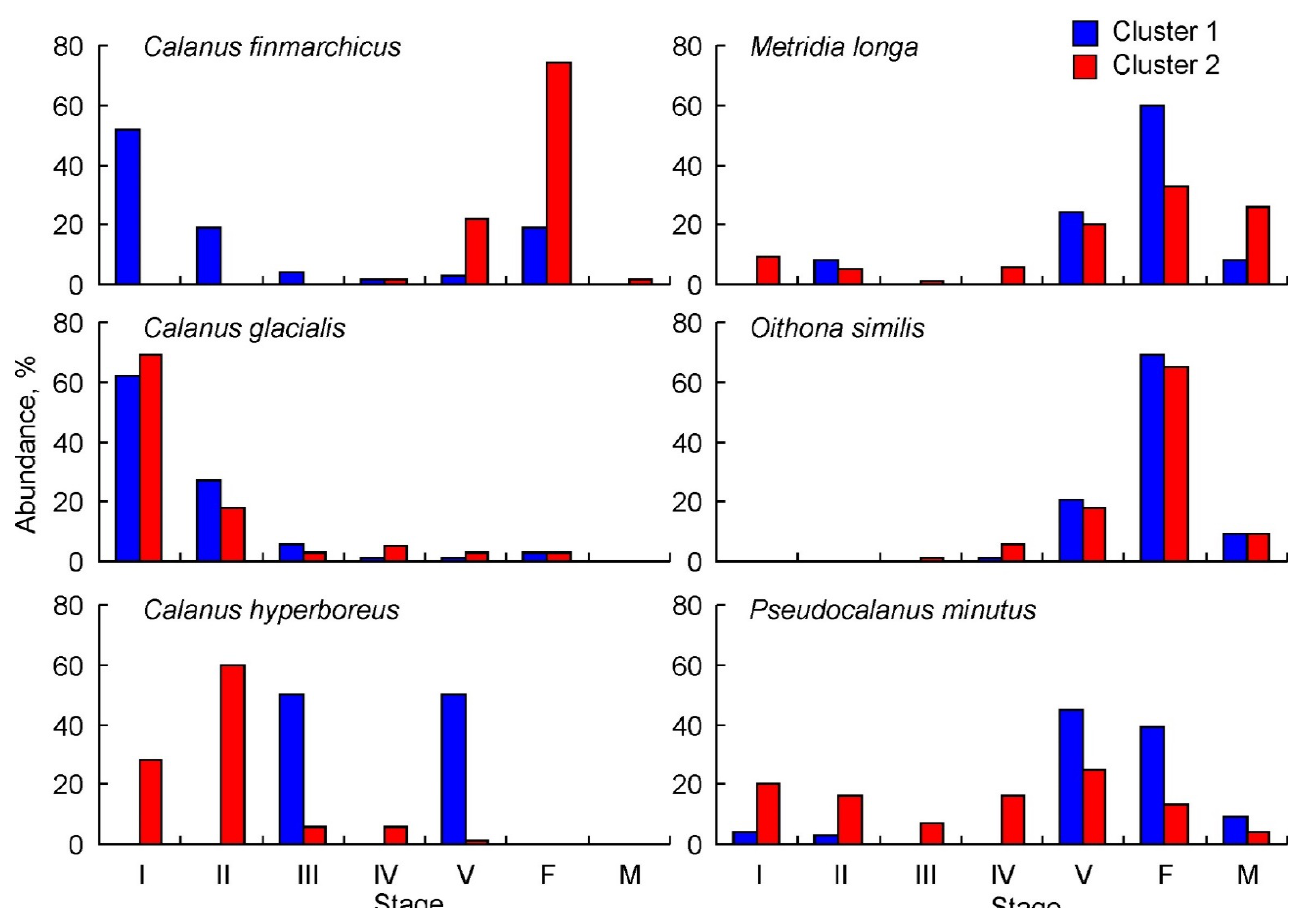
Figure 5. Population structure of common copepod taxa in the eastern Barents Sea in May 2016. I–V—copepodites I–V; F—female; M—male.